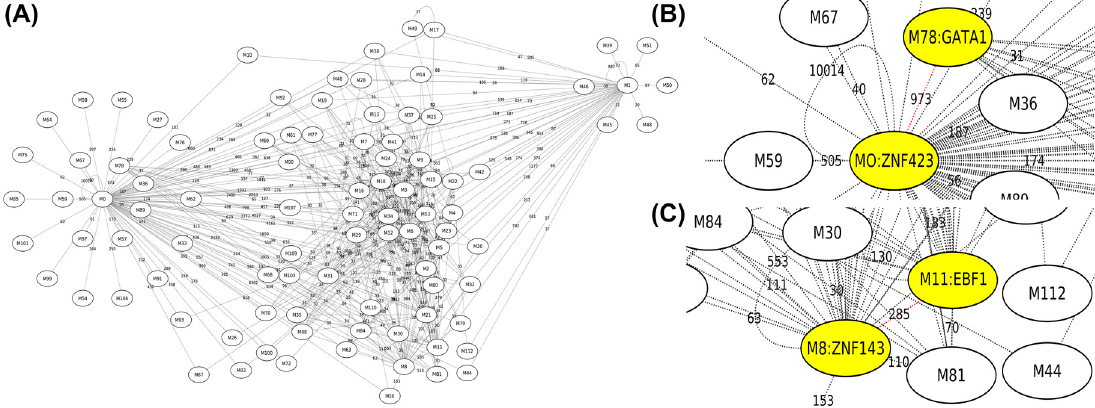
Figure 3: (A) The 423 motif pairs discovered in a network. (B) The TF pair GATA1-ZNF423 in the network. (C) The TF pair EBF1-ZNF143 in the